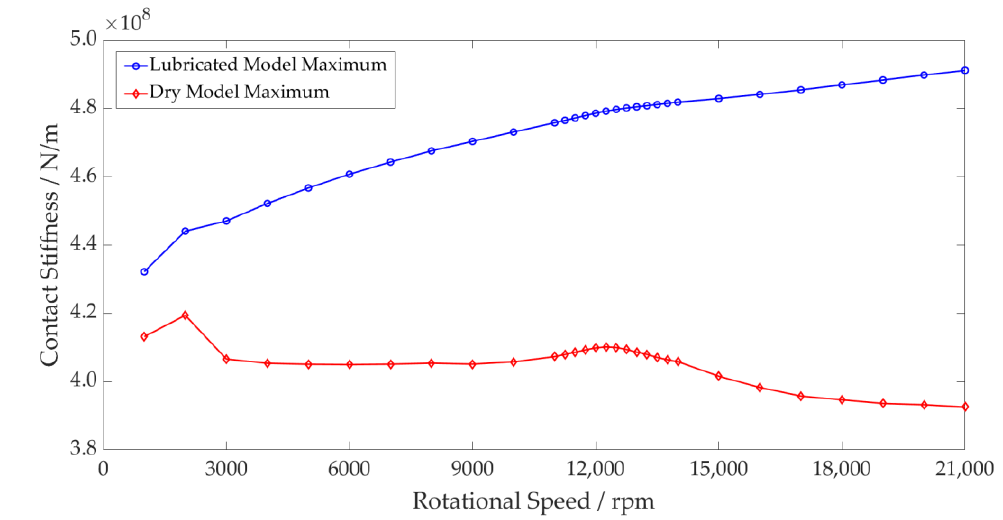
Figure 7. Rolling Element Contact Stiffness — Dry vs. Lubricated Maximum Values.